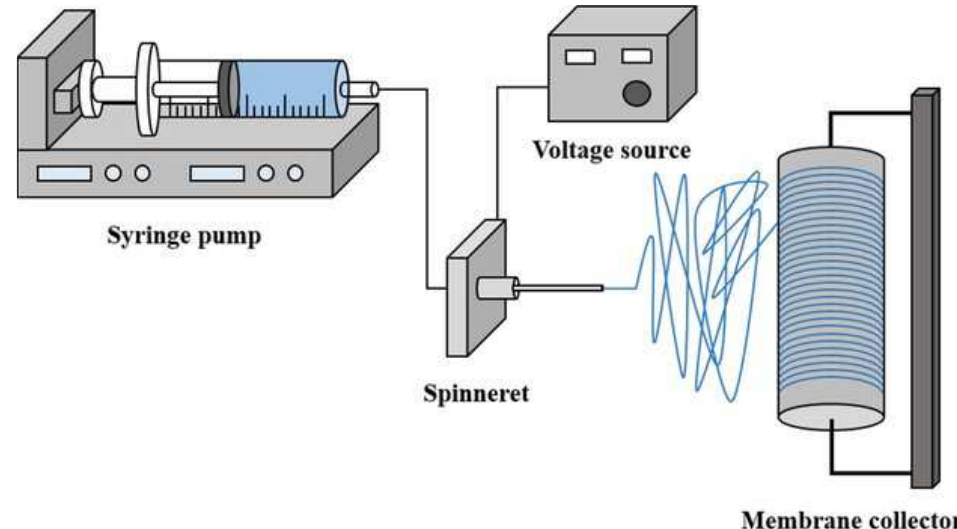
Figure 4. The electrospinning setup for fabrication of nanofibers. Reproduced from [79], MDPI, 2018.